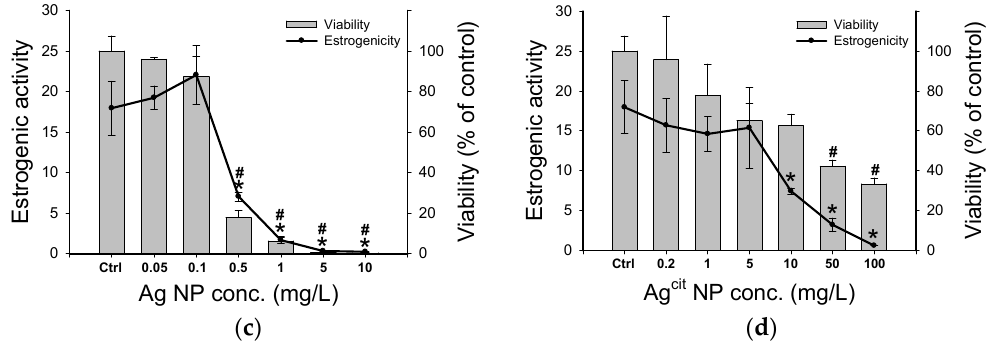
Figure 2. Viability and estrogenic activity of yeast exposed to ( a ) ZnO NP, ( b ) Al 2 O 3 NP, ( c ) Ag NP, and ( d ) Ag cit NP, in combination with 10 −6 M E2. Asterisks for estrogenic activity test and pounds for viability test indicate a significant difference relative to the control ( p < 0.05), using Dunnett’s post hoc test.